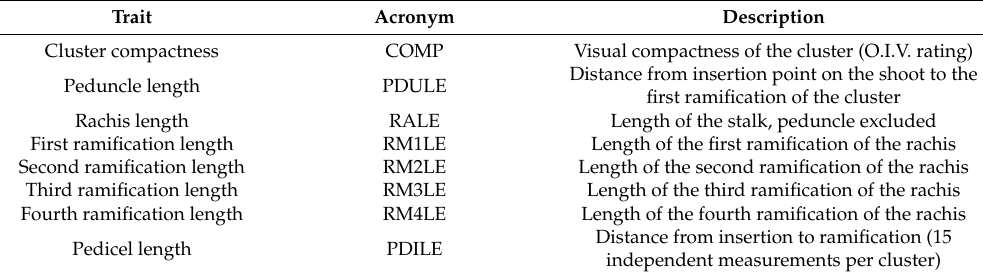
Table 1. List of traits evaluated in this